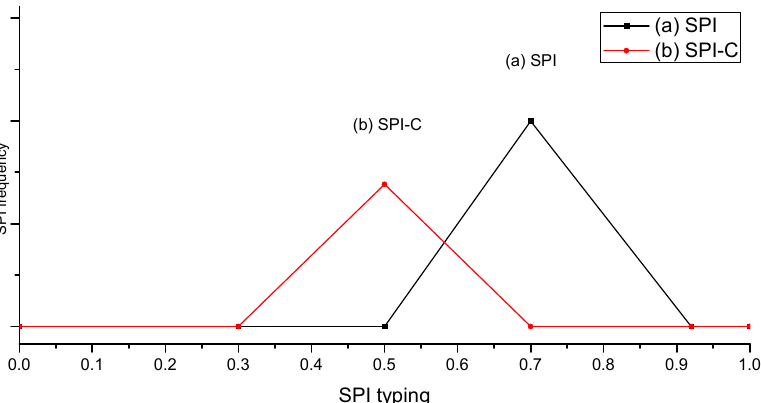
Figure 1. SPI typing. (a) Standardized precipitation index (SPI); (b) standardized precipitation index corrected (SPI-C).